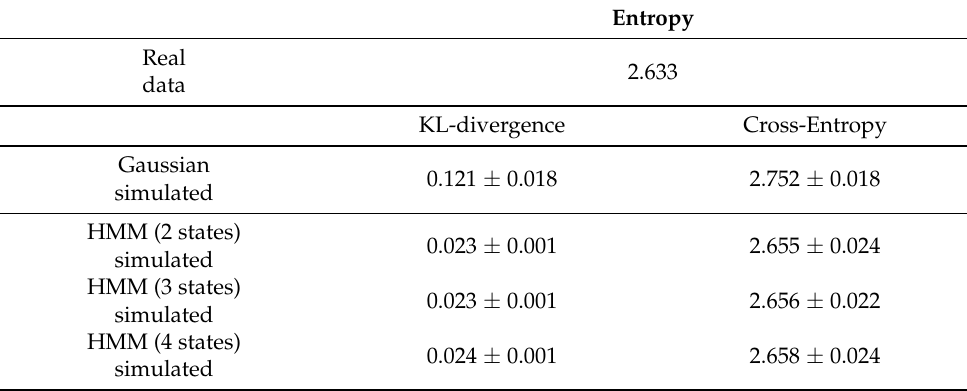
Table 1. Entropy H ( P ) , Kullback–Leibler divergence D KL ( P | Q ) , and cross-entropy H ( P , Q ) for the empirical probability distribution functions of real data P and simulated data generated with a Gaussian probability distribution function and an HMM model with 2, 3, and 4 states Q . Fifty iterations were performed to build the HMM models; 10,000 experiments with 1000 samples each were